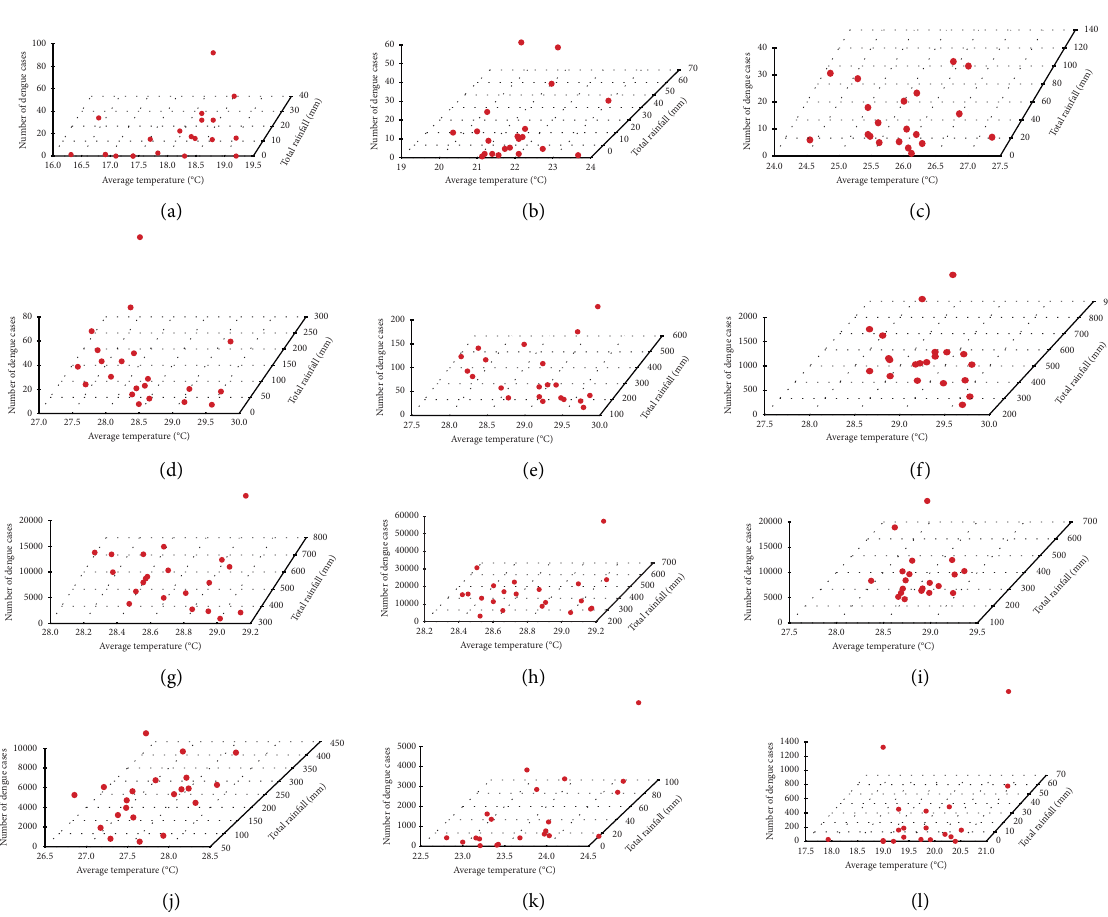
Figure 3: Te impact of a particular month’s daily average temperature and total rainfall on monthly dengue cases. Dots represent monthly dengue cases at diferent values of the total rainfall and daily average temperature in a particular month (January to December) of diferent years (2000 to 2021). Here, (a) January, (b) February, (c) March, (d) April, (e) May, (f) June, (g) July, (h) August, (i) September, (j) October, (k) November, and (l) December month’s dengue cases at diferent values of the total rainfall and daily average temperature of diferent years (2000 to